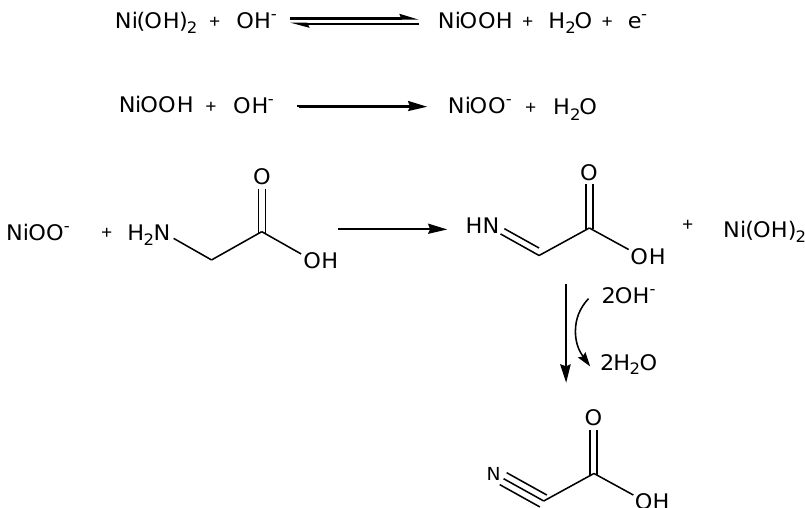
Figure 3. ( a ) Cyclic voltammograms of Ni in 1 mol L −1 KOH in the presence of 20 mmol L −1 glycine under different cycle numbers, ( b ) relative anodic-peak current density and anodic-peak current density (inset) as a function of nickel hydroxide loadings for glycine electrooxidation. Ni(OH) 2 + OH